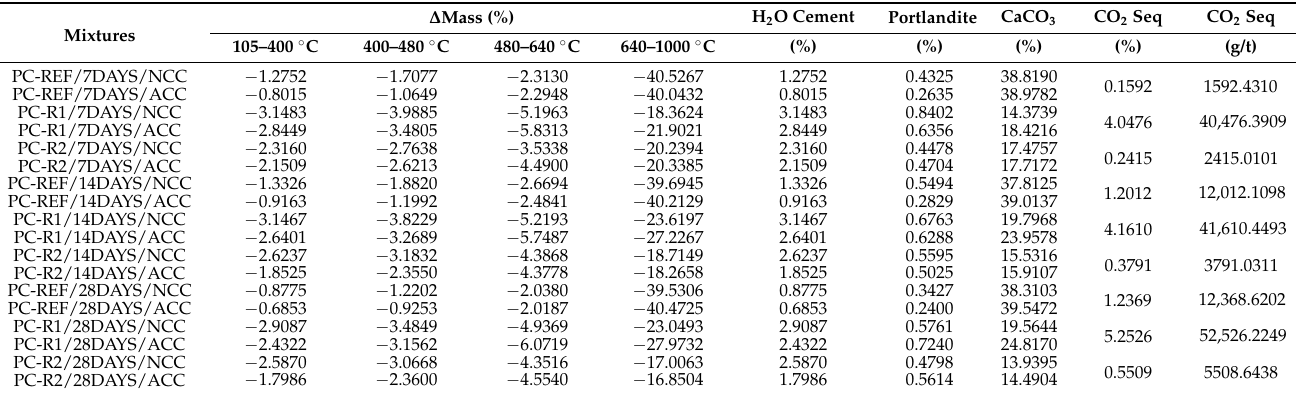
Table 4. CO 2 sequestration results for each mixture in the different curing environments for curing of 7, 14 and 28